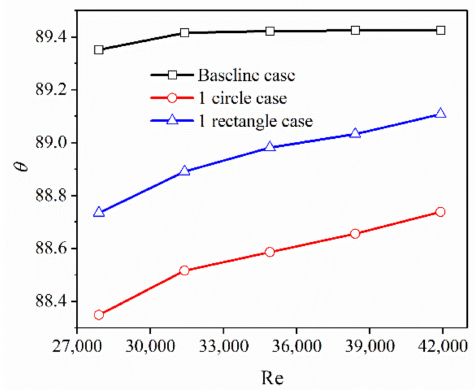
Figure 12. Synergy angle distribution in three cases.